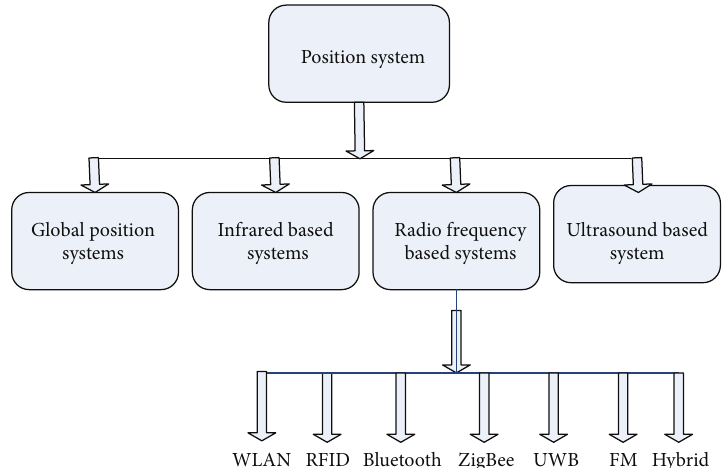
Figure 7: Taxonomy of position